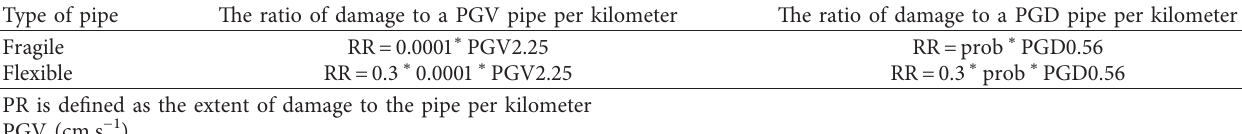
Table 2: Hazus equations concerning the ratio of damage to a buried pipeline.